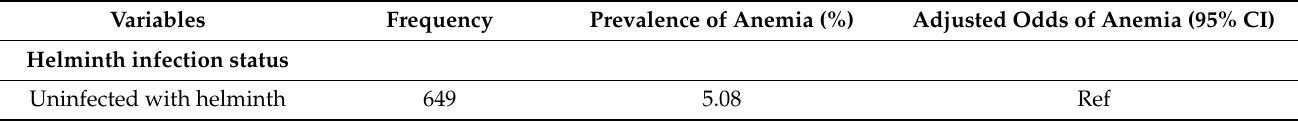
Table 3. Comparison of the odds of anemia by helminth infection status, nutritional status, age group, and gender among school children in Maksegnit from June to July 2021 (N =